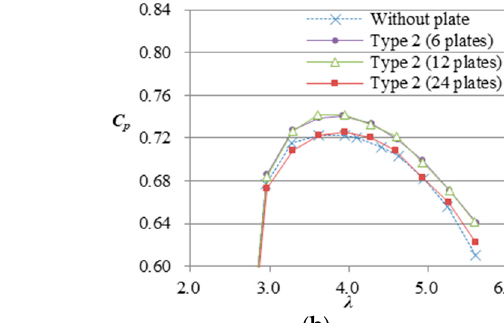
Figure 9. The various WLT brim shapes modeled in the numerical simulations: ( a ) Ci05 (circular brim, h = 0.05 D throat ); ( b ) Ci05_L6 (hexagon brim with straight sides, h = 0.05 D throat ); ( c ) Ci05_C6 (hexagon brim with curved sides, h = 0.05 D throat ); ( d ) Ci05_L12 (dodecagon brim with straight sides, h = 0.05 D throat ); ( e ) Ci05_C12 (dodecagon brim with curved sides, h = 0.05 D throat ).